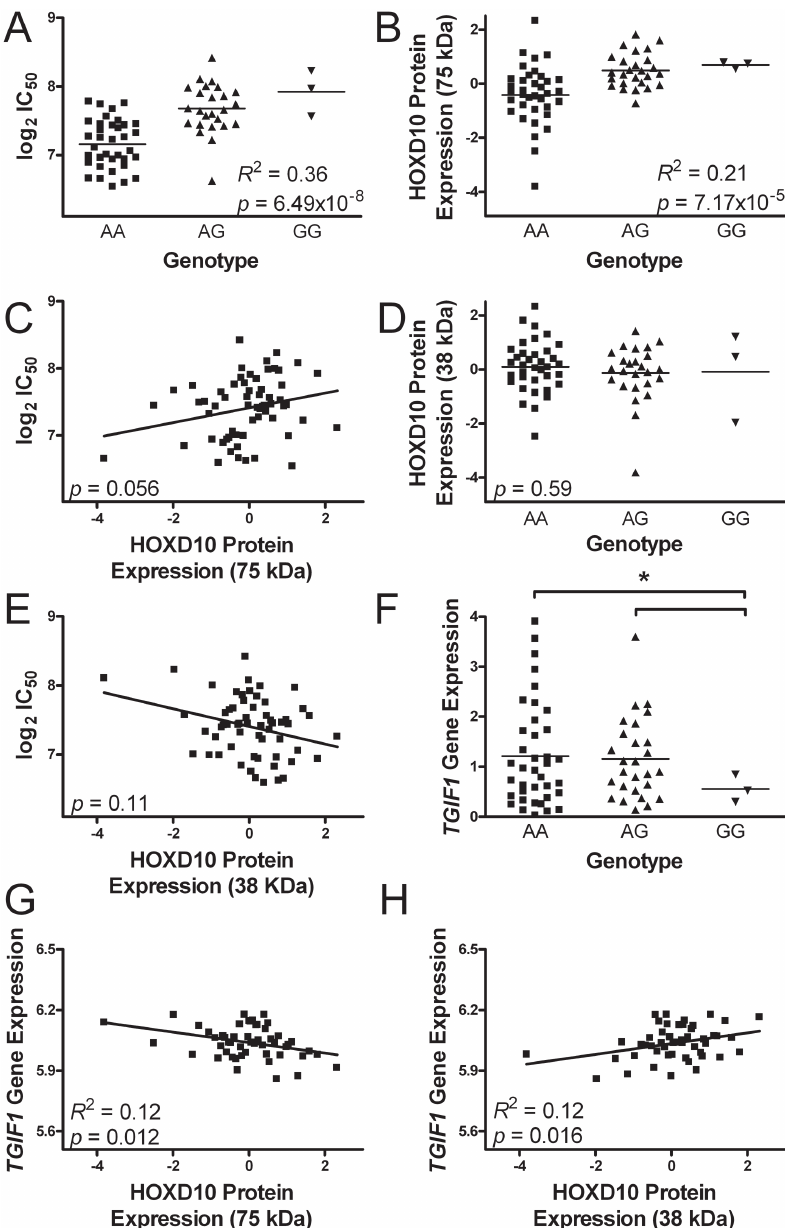
Figure 3. Association studies of chr18:3417240, TGIF1 (transforming growth factor β (TGF β )-induced factor-1) and the protein HOXD10 (homeobox protein D10): ( A ) The SNP chr18:3417240 is associated with colistin cytotoxicity (log 2 IC 50 ) at p = 6.47 × 10 − 8 ; ( B ) Chr18:3417240 was associated with expression of HOXD10 (75 kDa isoform) at p = 7.17 × 10 − 5 ; ( C ) HOXD10 protein expression (75 kDa) was not significantly associated with colistin cytotoxicity at p = 0.056; however, the direction of effect for this result is consistent with A and B; ( D ) Chr18:3417240 was not associated with expression of HOXD10 (38 kDa isoform) at p = 0.59; ( E ) HOXD10 protein expression (38 kDa) was not significantly associated with colistin cytotoxicity at p = 0.11; ( F ) the homozygous recessive (GG) genotype of chr18:3417240 had significantly lower TGIF1 gene expression than heterozygous (AG, p = 0.031) or homozygous dominant (AA, p = 0.021) lymphoblastoid cell lines; ( G ) TGIF1 gene expression is associated with HOXD10 protein expression (75 kDa) at p = 0.012 (from Illumina array); and ( H ) TGIF1 gene expression is associated with HOXD10 protein expression (38 kDa) at p = 0.016 (from Illumina array). The association between TGIF1 gene expression and either 75 kDa or 38 kDa HOXD10 protein expression was not significant as measured by the RNA sequencing platform (see Figure